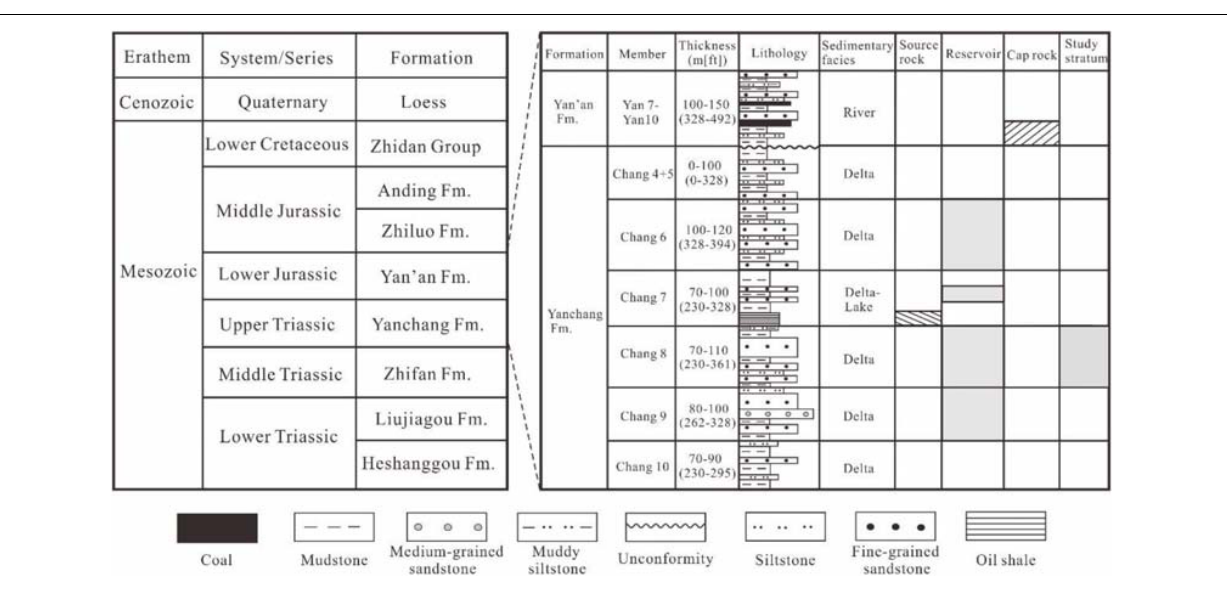
horizontal compressive stress is 60–70 ◦ . The value of present in situ stress has a good linear relationship with buried depth, and the stress gradients of the maximum, intermediate, and minimum principal stresses are 0.0301, 0.0212, and 0.0165 MPa · m − 1 , respectively (Zeng and Li, 2009; Lyu et al.,